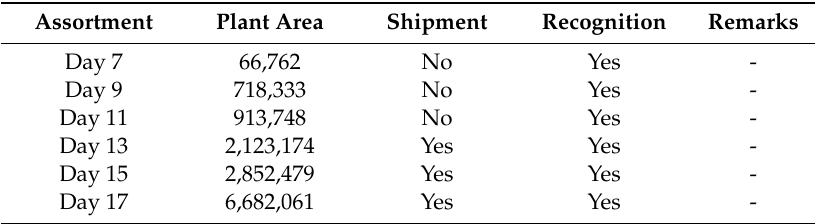
Table 4. Plant growth image processing